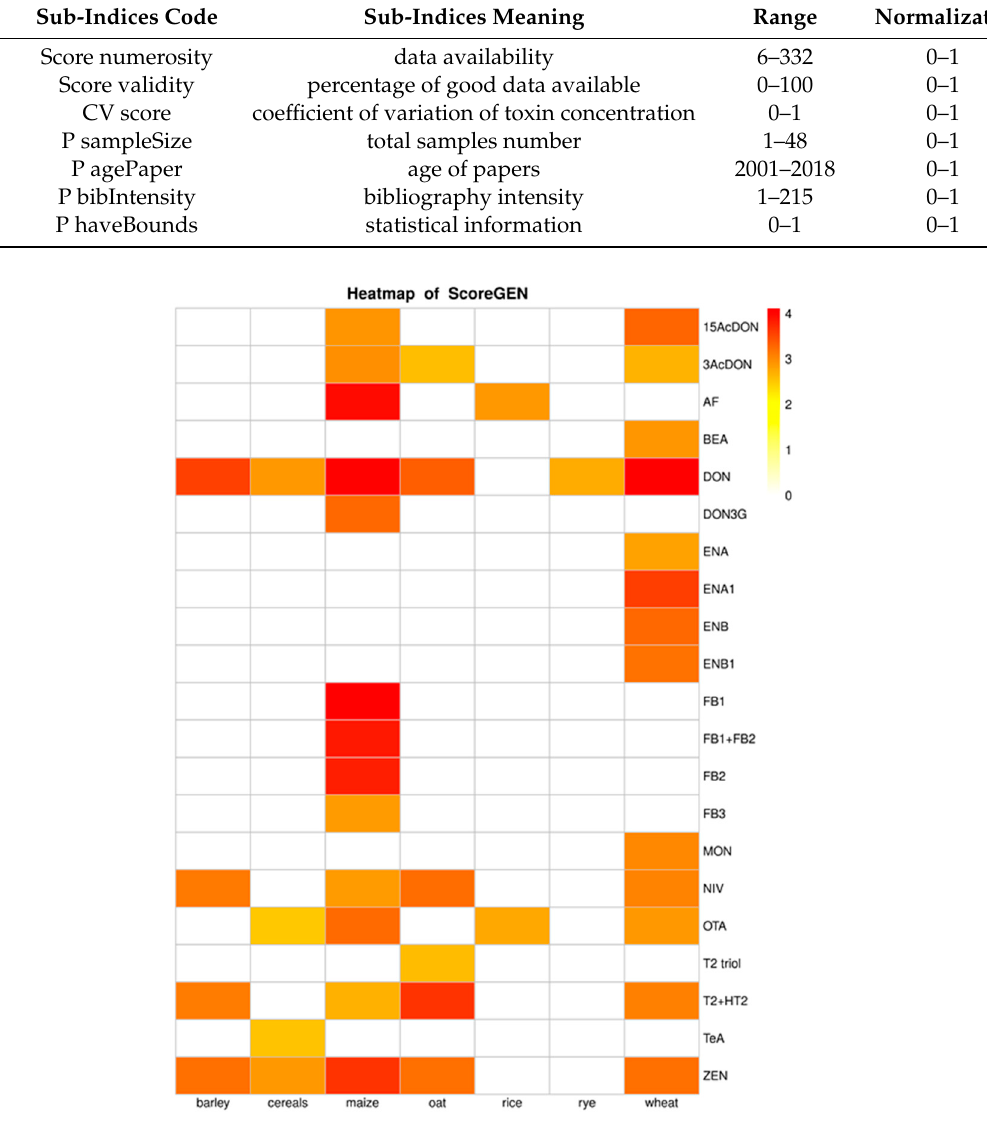
Figure 6. Score gen heatmap for mycotoxin crops with a score higher than 1.4.